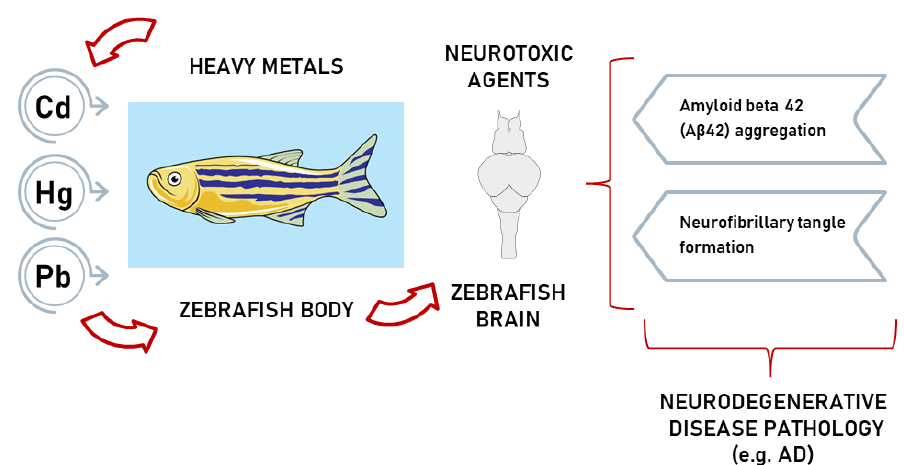
Figure 4. Exposure to highly toxic metals (Cd, Hg, Pb) induces neurological deficiency in the zebrafish body (data modified from Thawkar and Kaur